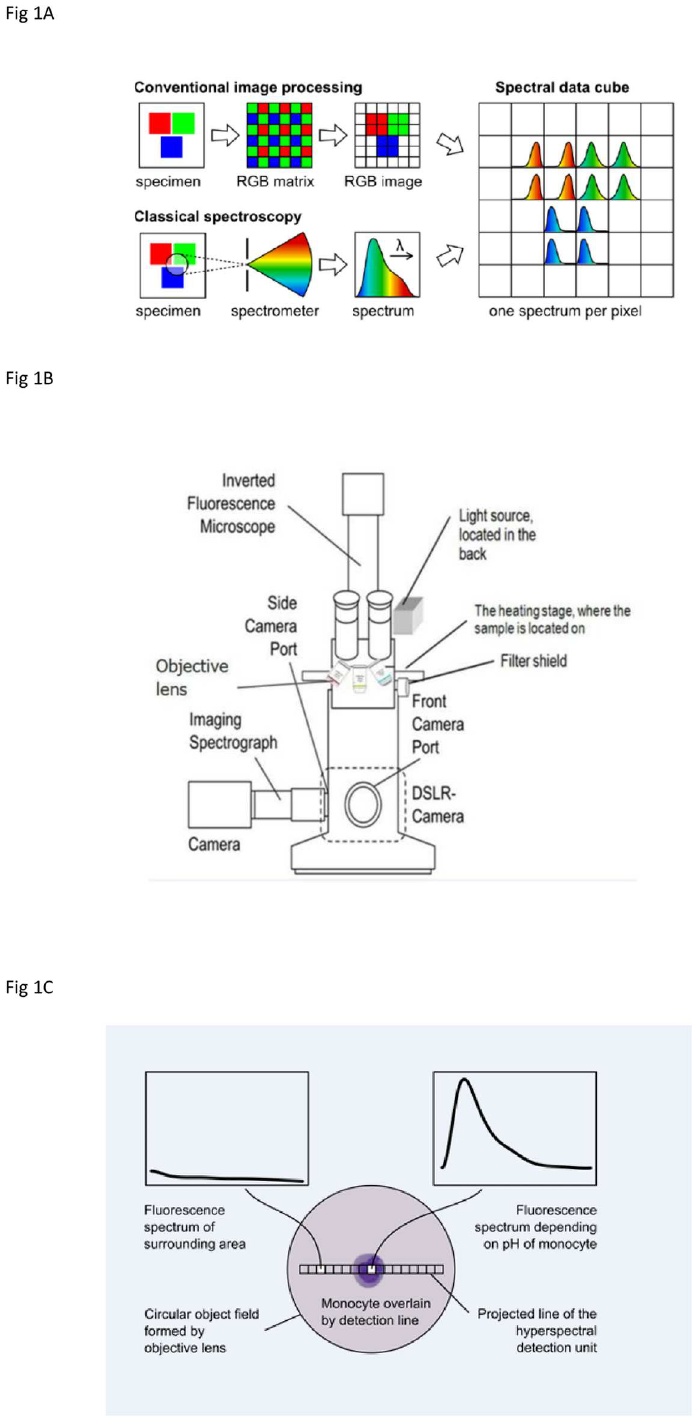
Fig 1. Principle of hyperspectral imaging (HSI) as a combination of conventional image processing and classical spectroscopy. (A) Hyperspectral data cube includesa set of data that are layeredon top of one another. Each pixel in the cube consists of an entire spectrum and the resulting image represents the corresponding wavelength band. Typically in hyperspectral imagery, the spatial informationis collected in the X-Y plane and spectral information represented in the Z-direction [44]. (B) HSI detector attached to side camera port of an inverted microscope. This combination comprises the imagingspectrograph with